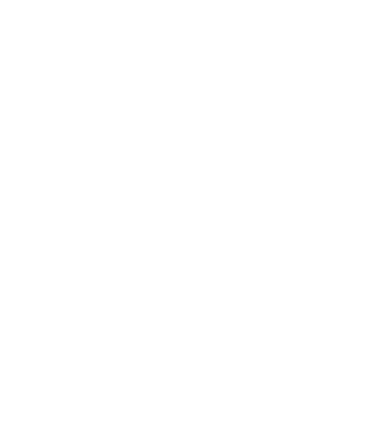
Figure 3. Prebiotic effect of honey and unprocessed fiber on the digestive system. Created with BioRender.com. The intestinal tract health can be supported both by introducing fiber to the diet and by the moderate consumption of honey. Figure 4 shows different vegetables, fruits and seeds that are high in fiber.